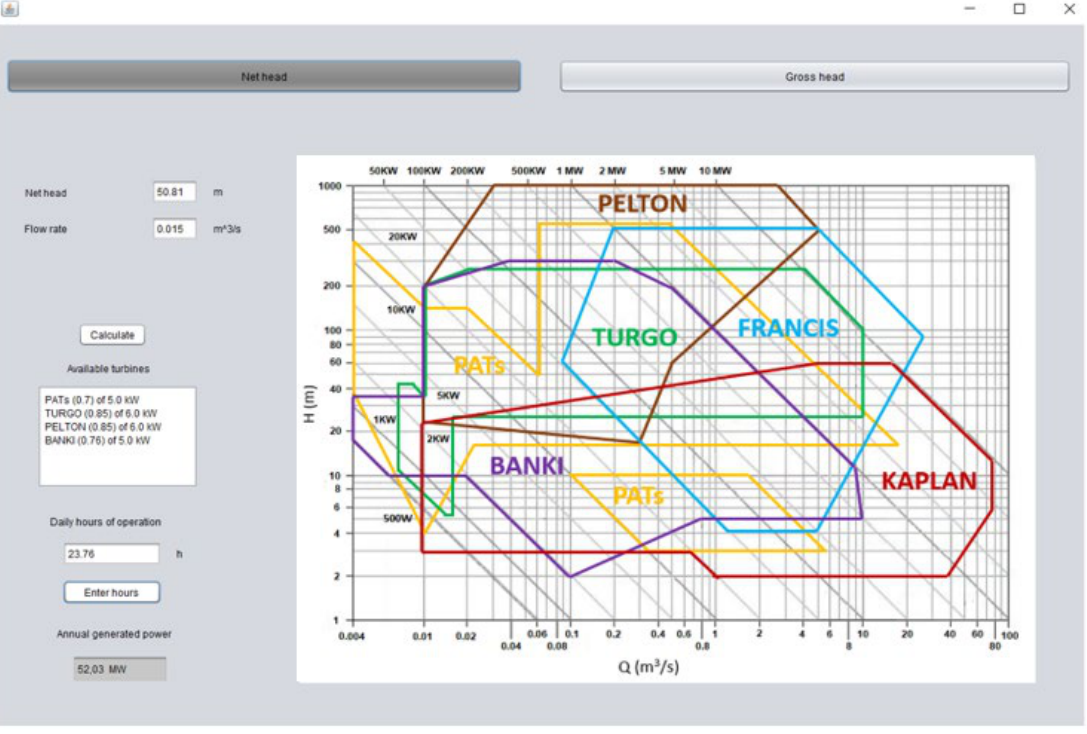
Figure 4. Main window of the computer application developed: results of case study 2.